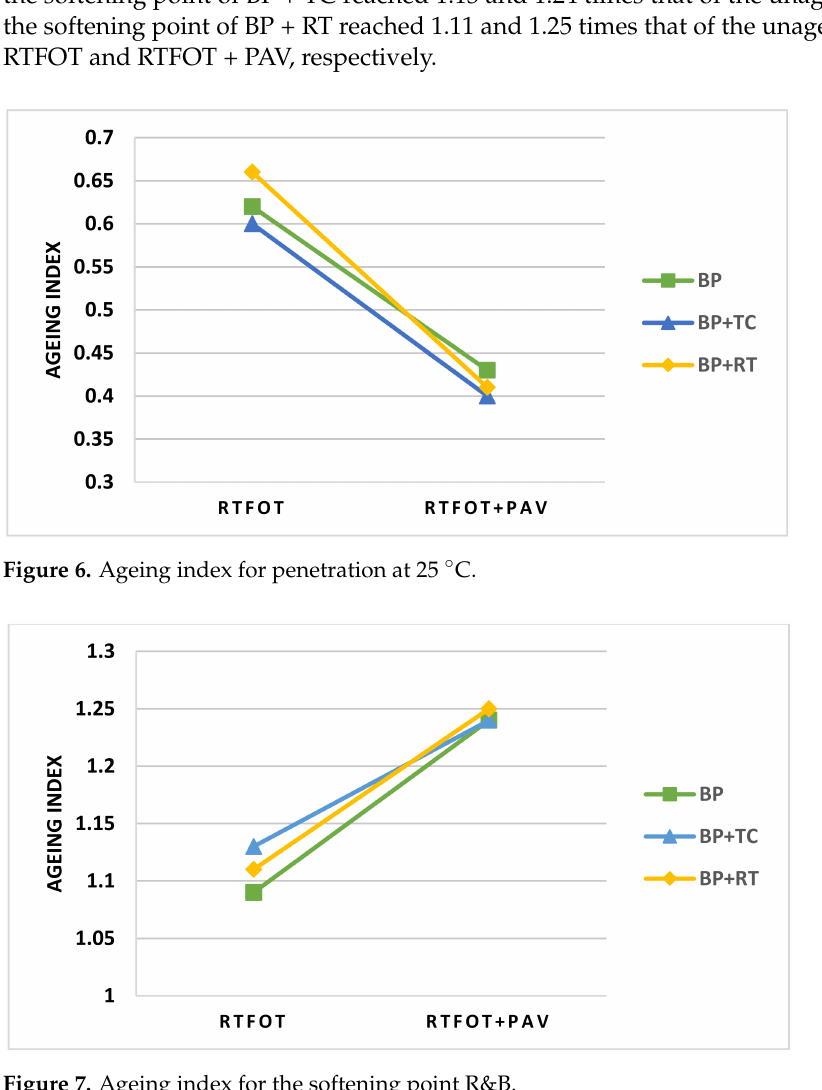
Figure 7. Ageing index for the softening point